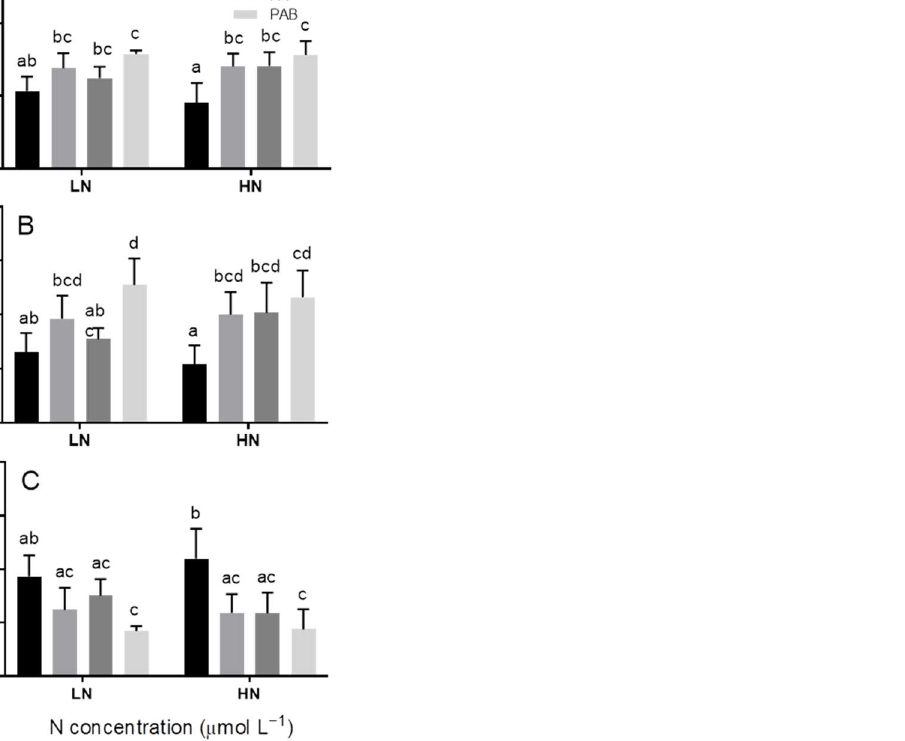
Figure 6. V J ( A ), M 0 ( B ), and Ψ 0 ( C ) of Sargassum horneri under P, PA, and PAB treatments. Significant differences among all treatments are indicated by different lowercase letters ( p < 0.05).